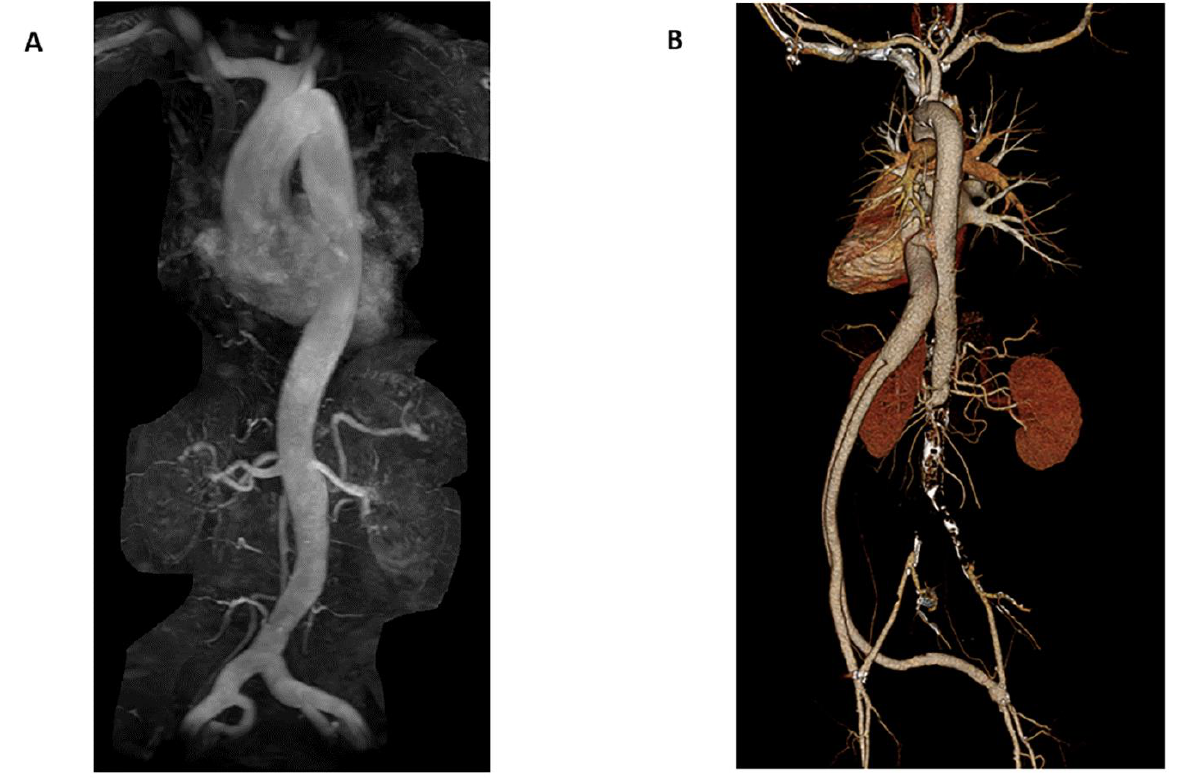
Figure 2. Coronal MIP MRA of the chest, abdomen, and pelvis ( A ) in a 66-year-old female for evaluation of possible aortic aneurysm demonstrates mild ectasia of the common iliac arteries bilaterally; however, no abdominal aortic aneurysm (AAA). 10 mL of Prohance contrast was administered. Coronal CTA volume rendered images ( B ) in a 70-year-old male with history of aortobifemoral bypass for suspected dissection demonstrates chronic occlusion of the infrarenal abdominal aorta and patent bypass. No dissection. 70 mL of Isovue contrast was administered with CTDIvol 19.2 mGy.